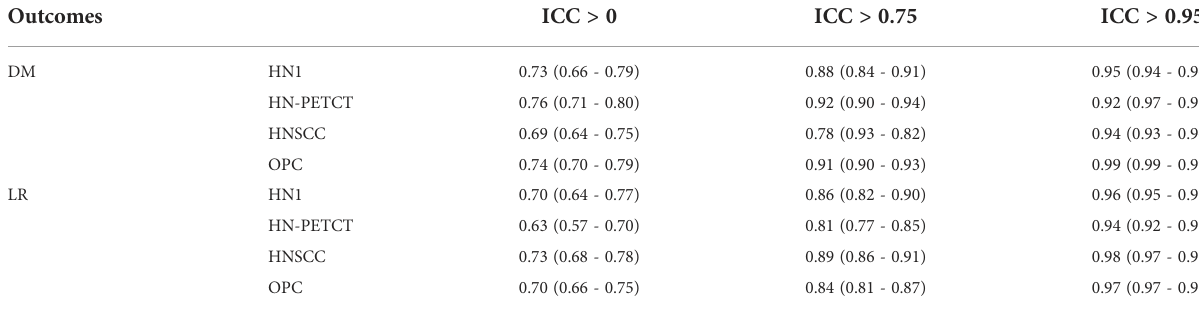
TABLE 3 The model robustness (ICC) for different feature robustness pre-screening thresholds.